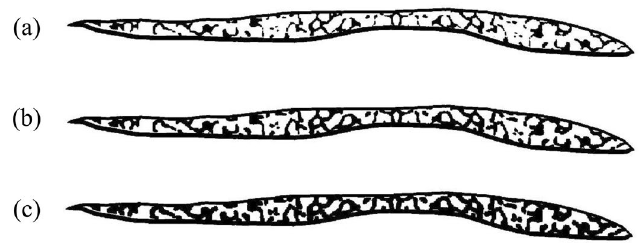
Figure 3. Three bone models of sample C with different BV/TV. ( a ) 50%, ( b ) 60% and ( c ) 70%.